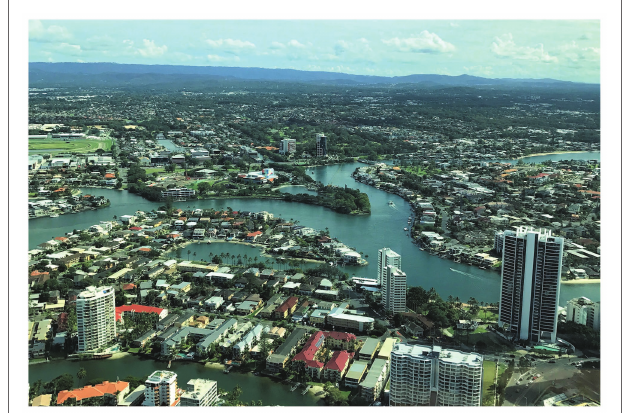
FIGURE 1 | Aerial photo of Surfers Paradise on the Gold Coast facing west (photo by Siyao